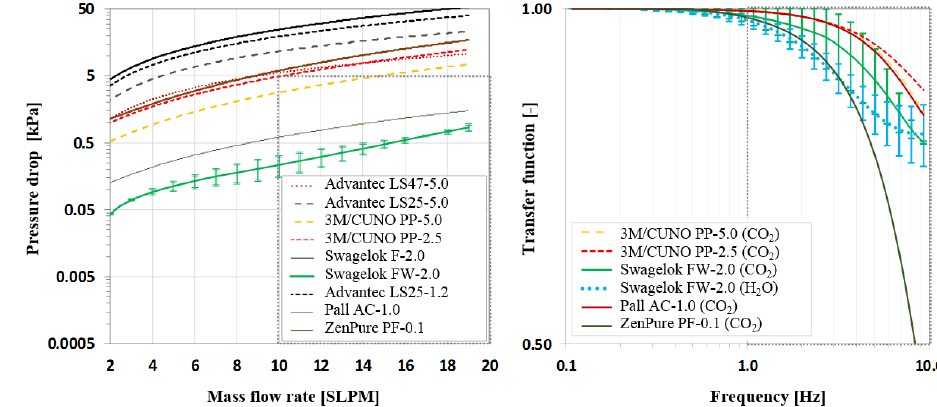
Figure 4. Optimization of an intake particulate filter as determined by laboratory tests. Dotted grey boxes indicate approximate desirable ranges for a short-tube low-power implementation, requiring minimal corrections. Left panel: pressure drop of nine tested filters at different flow rates, without tube and rain cap (Table 2 provides detailed filter specifications). Please note the log-scale of the y axis. Right panel: transfer function of five selected filters, without tube, rain cap, heating or insulation. Please note that the y axis starts at 0.5. Bars indicate range from multiple experiments, where available, as described in Sect.